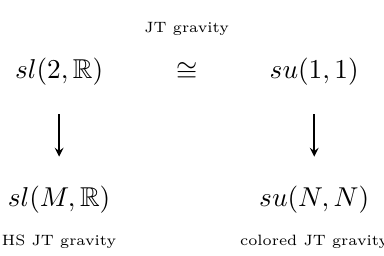
Figure 1 . Two possible tracks to extend original AdS 2 global isometry algebra and respective extensions of JT gravity which in both cases is embedded as a